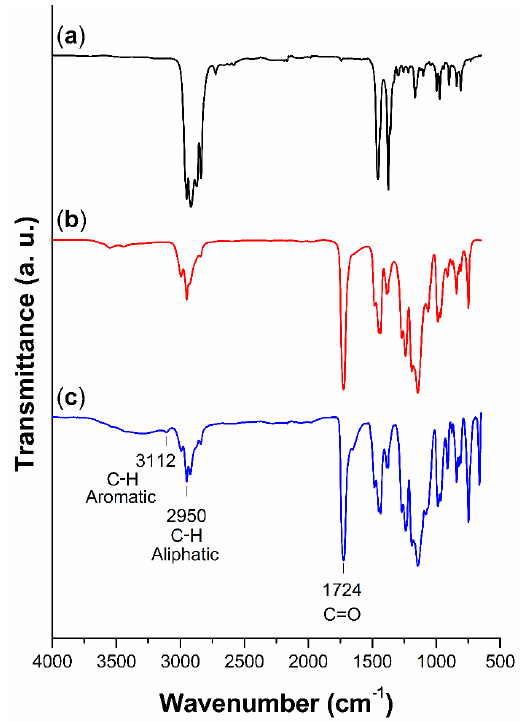
Figure 4. FTIR spectra: ( a ) non-irradiated PP, ( b ) PP- g -MMA (10%), and ( c ) (PP- g -MMA)- g -NVI (77.5/5%).